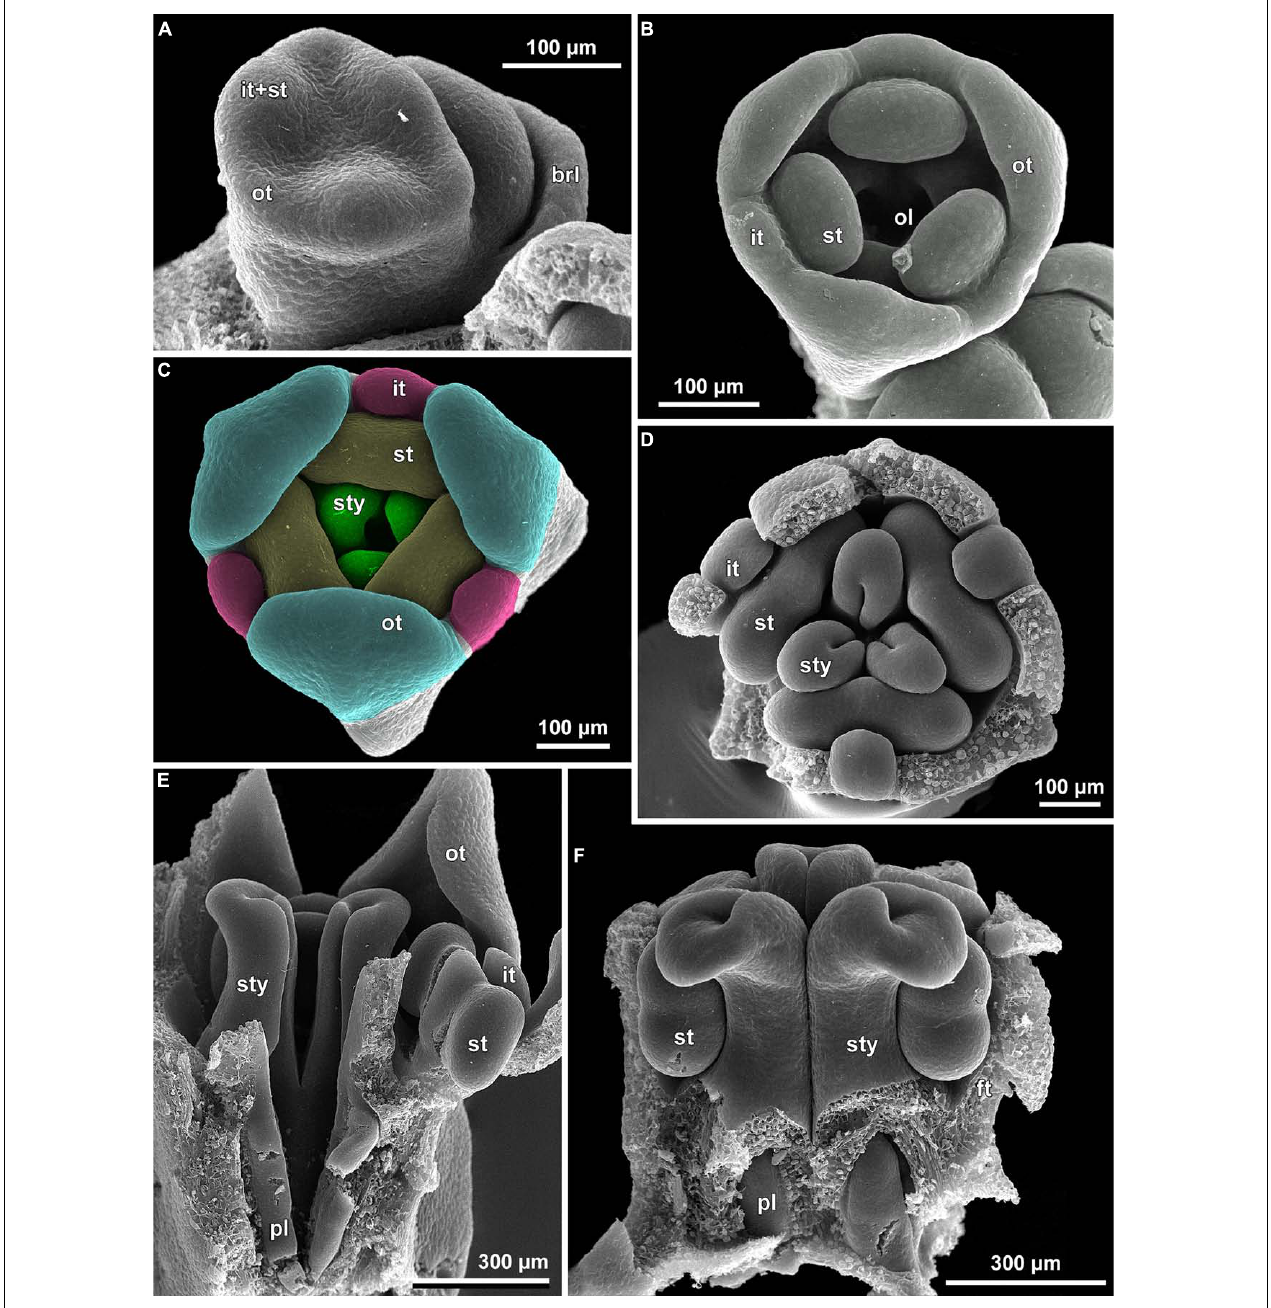
FIGURE 10 | Floral development of Burmannia disticha (SEM). (A) Flower with primordia of outer tepal lobes and common primordia of inner tepal lobes and stamens. (B) Flower after initiation of ovary locule. (C) Flower after initiation of styles. (D,E) Flowers before congenital fusion of styles; top view with outer tepal lobes removed (D) and longitudinal section (E) . (F) Flower at congenital fusion of styles and development of placentas, longitudinal section. brl, bracteole; ft, floral tube; it, inner tepal; ol, ovary locule; ot, outer tepal; pl, placenta; st, stamen; sty, style.